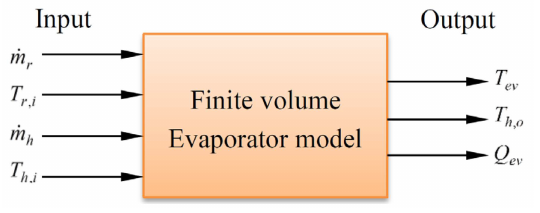
Figure 5. Input-output of finite volume evaporator